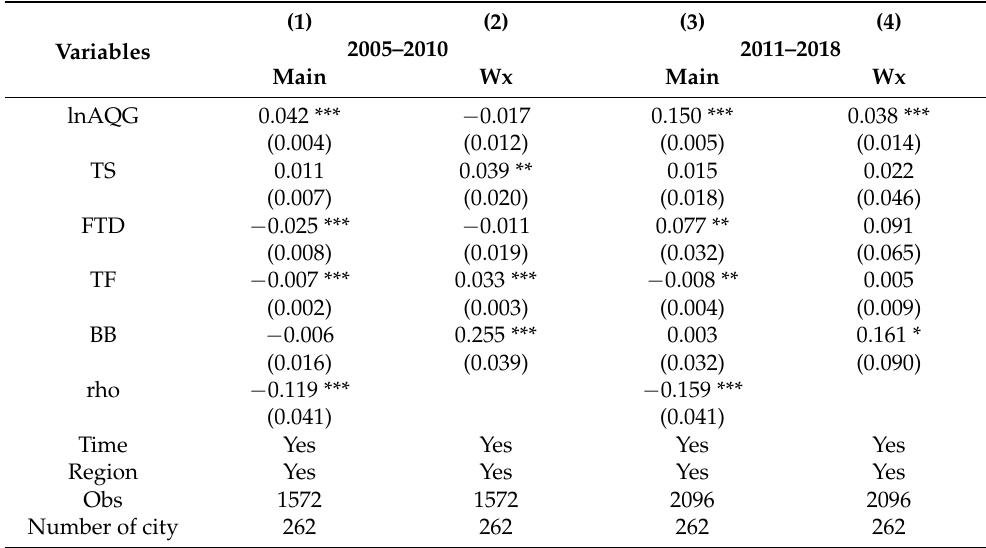
Table 7. Impact of air quality improvement on enterprise productivity for the periods 2005–2010 and 2011–2018.